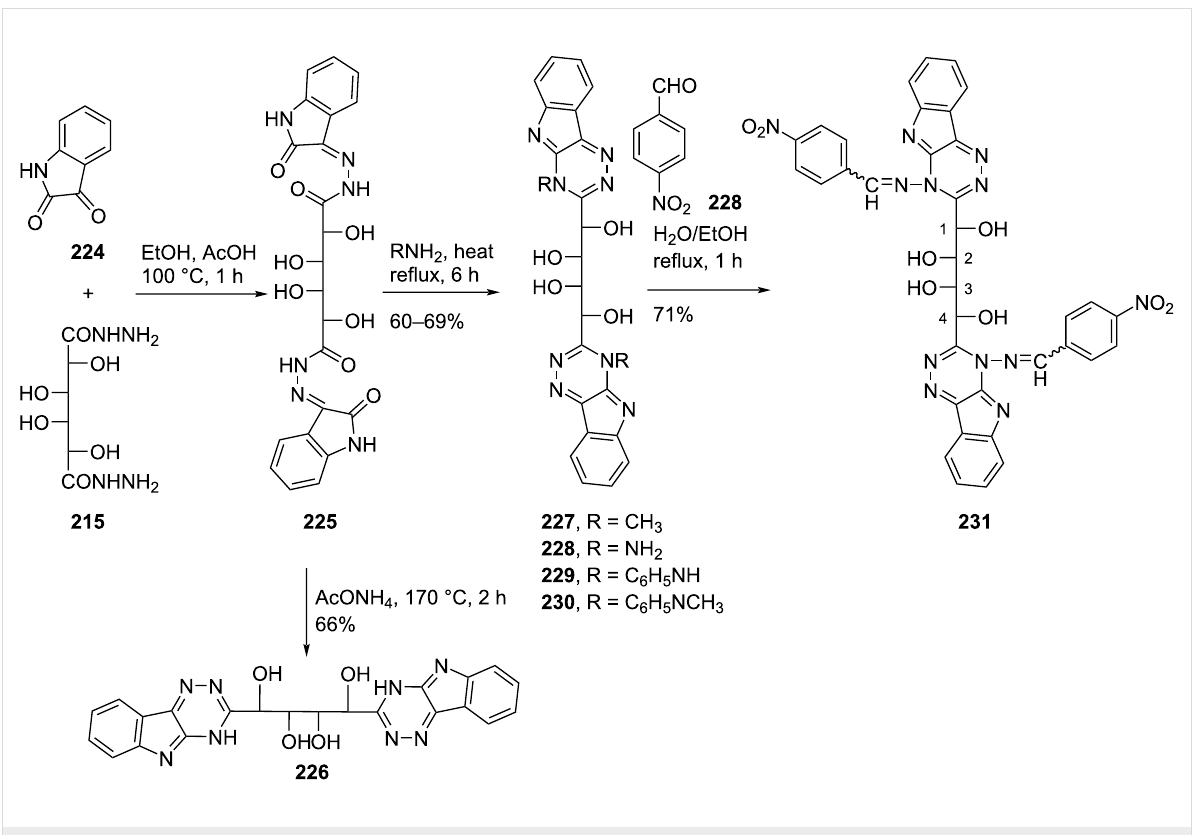
The structural and electronic properties of the double-headed nucleosides were explored theoretically by performing semi- empirical molecular orbital, ab initio Hartree–Fock (HF), and density functional theory (DFT) calculations and their geome- tries were optimized at the level of Austin Model 1 (AM1)